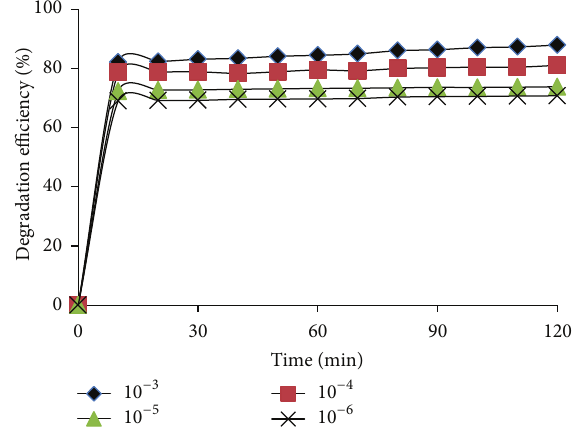
Figure3:EffectofFe 3+ concentrationonthediscolorationefficiency forFenton-likeoxidationprocess,([H 2 O 2 ]=5.0 × 10 −2 ,[MAG]=3.0 × 10 −5 M).